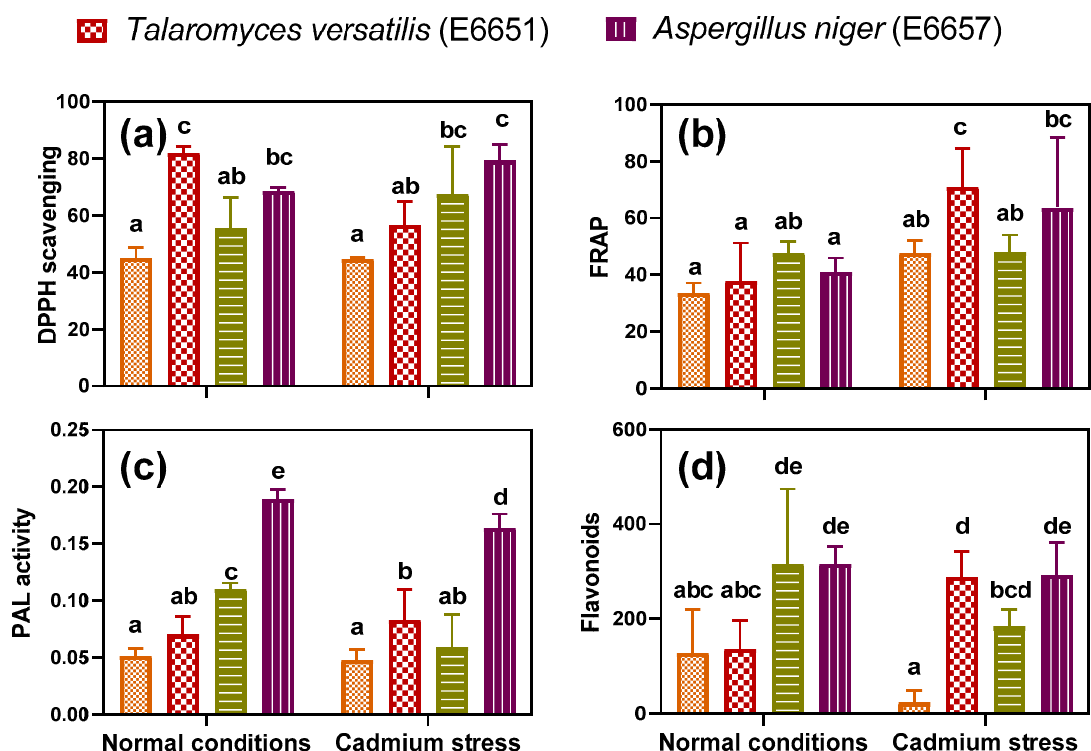
Figure 4. ( a ) The scavenging activity of the free radical 1,1-diphenyl-2-picrylhydrazyl (DPPH scavenging, %), ( b ) ferric ion reducing antioxidant power (FRAP, µ mol g − 1 FW), ( c ) phenylalanine ammonia-lyase (PAL, µ mol trans-cinnamic acid g − 1 FW h − 1 ) activity and ( d ) flavonoids (mg quercetin g − 1 dry wt) content of leaves of geranium non-inoculated (NI) or inoculated with different endophytic fungi; T . versatilis (E6651), E . nidulans (E6658) and A . niger (E6657) under normal conditions and Cd-stress; after 17 days of applying stress. Values are expressed as means ± SE ( n = 3–4). For comparison among different treatments within and between levels of both normal conditions and cadmium stress, values with at least one similar letter are non significantly different according to One-way ANOVA with Post Hoc-Tukey HSD test ( p ≤ 0.05).